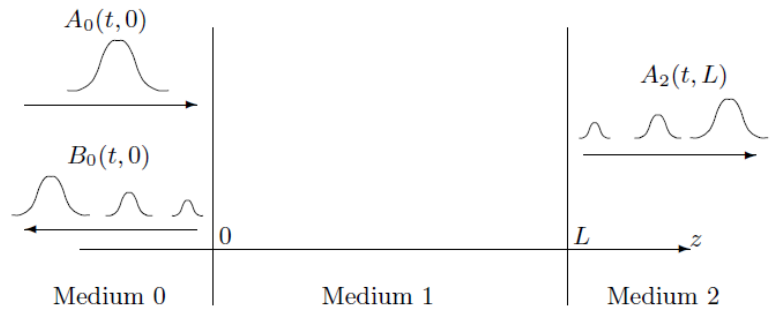
Figure 5. Scattering of a pulse by a single